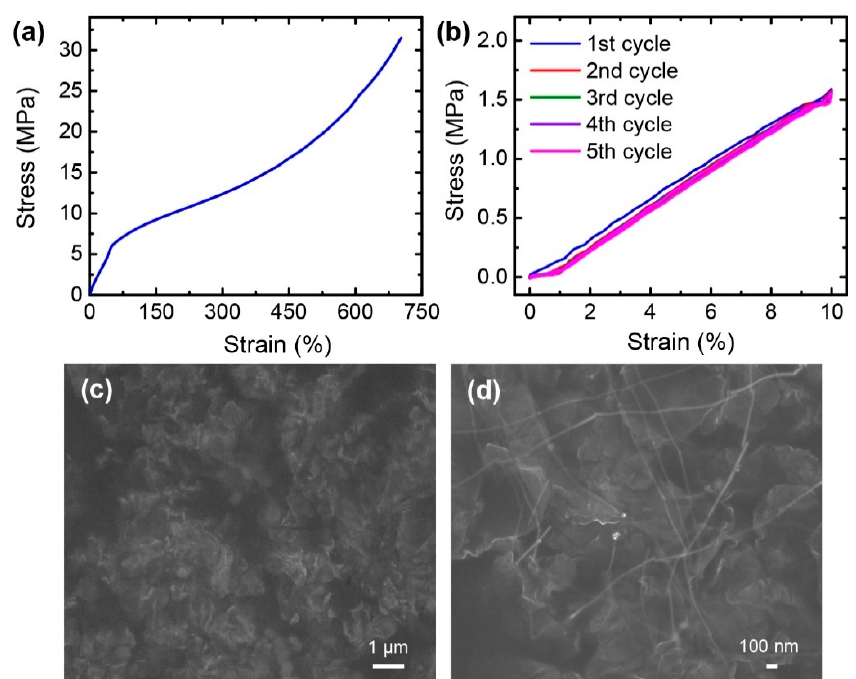
Figure 2. ( a ) Stress–strain curve of the neat spandex film; ( b ) Stress–strain curves of the neat spandex film under stretching and releasing cycles with a strain of 10%; ( c , d ) SEM images of the surfaces of the: ( c ) Graphene/spandex (G/SpX); ( d ) Graphene/AgNW/spandex (G/AgNW/SpX) composite films.